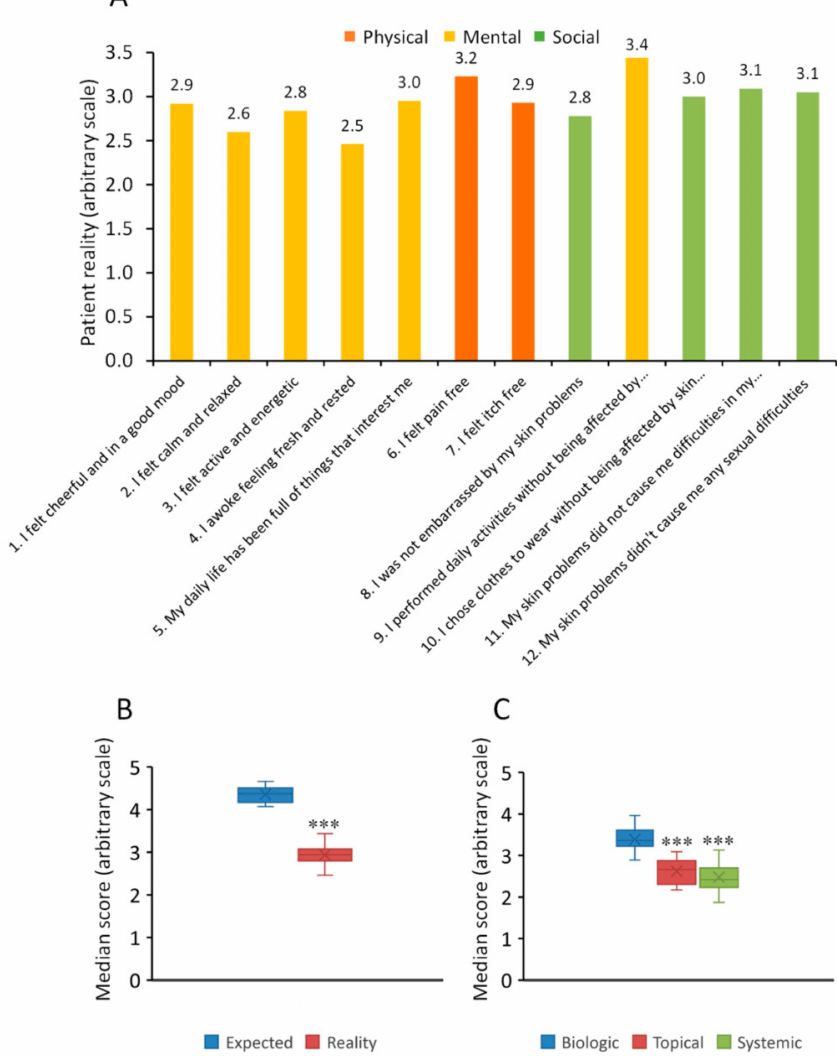
Figure 5. Rating of three core domains, physical, mental and social associated with achievement of pa- tient wellbeing and the effect of different treatment. ( A ) Q24: For each of the following 12 statements, please indicate the answer that comes closest to how you have felt in the last two weeks (assign a value from 0 to 5, where 0 = never and 5 = always). Scores given to each of these questions reflect the reality that patients are experiencing. ( B ) Box-whisker plot showing the median score for their expected and reality of their psoriasis. ( C ) Box-whisker plot showing the median score stratified by treatment type. Data presented as median, 25th/75th percentiles and maximum/minimum recorded values. *** p <